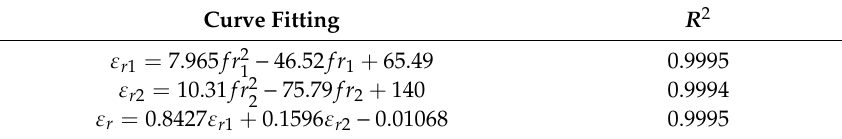
Table 3. Fitting curves to obtain permittivity as function of resonance frequency.